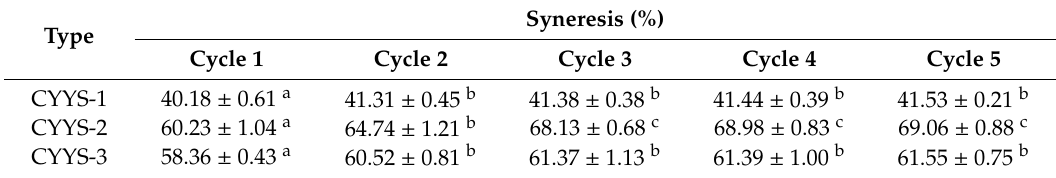
Table 2. Percentage of water separated (syneresis) of CYYS-1, CYYS-2, and CYYS-3 by freeze – thaw cycling (1 – 5) A.